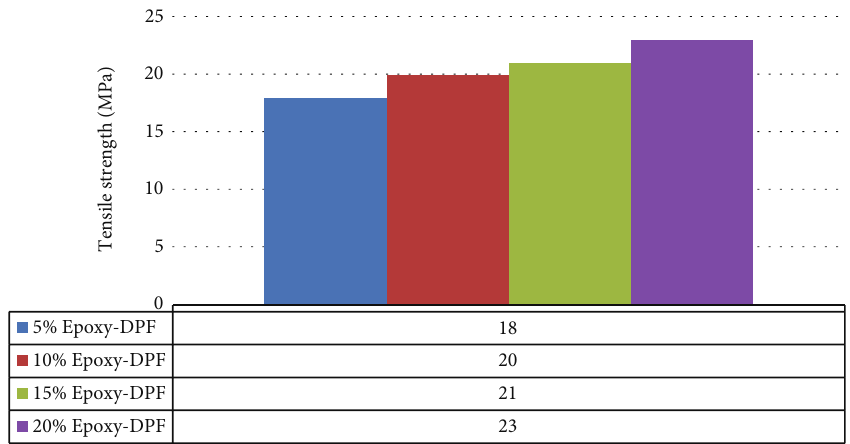
Figure 8: Tensile strength of Epoxy – DPF composites for di ff erent ratios of DPF (i.e., 5, 10, 15, and